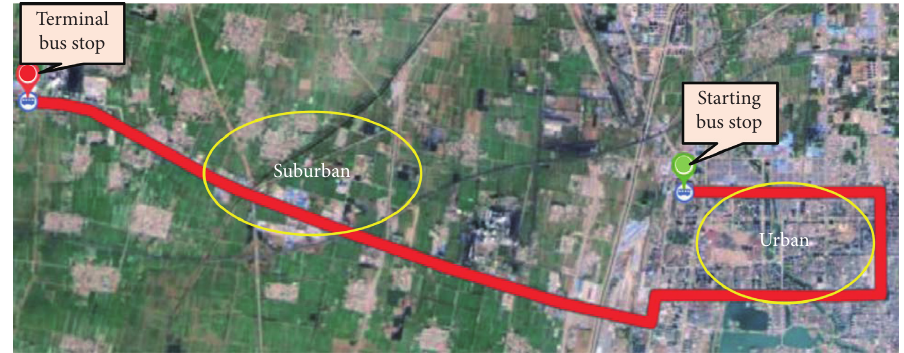
Figure 1: The selected bus route in Liaocheng, Shandong, China (Map data ©2019 Baidu). Table 1: Bus stop information for the round